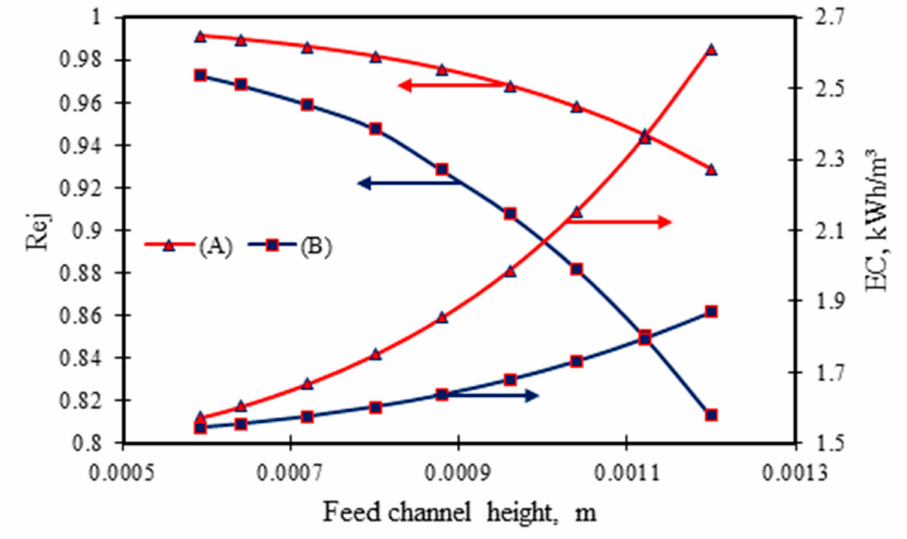
Figure 7. Influence of feed channel height of membrane module on dimethylphenol removal and energy consumption at fixed membrane area (operating parameters: ( A ) 6.548 × 10 − 3 kmol/m 3 , 2.583 × 10 − 4 m 3 /s, 13.58 atm and 31.5 ◦ C, and ( B ) 0.819 × 10 − 3 kmol/m 3 , 2.166 × 10 − 4 m 3 /s, 5.83 atm, and 32.5 ◦